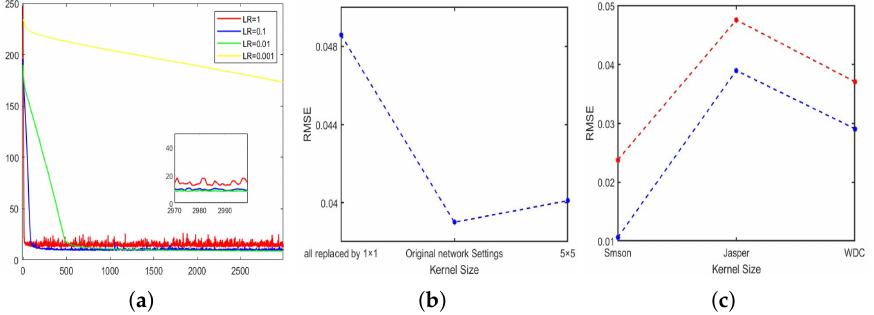
Figure 16. Sensitivity of SISLU-Net to the hyperparameters of the network. ( a ) Learning Rate (performed on the Jasper Ridge dataset) ( b ) Kernel Size (performed on the Jasper Ridge dataset) ( c ) Activation Function (performed on three real